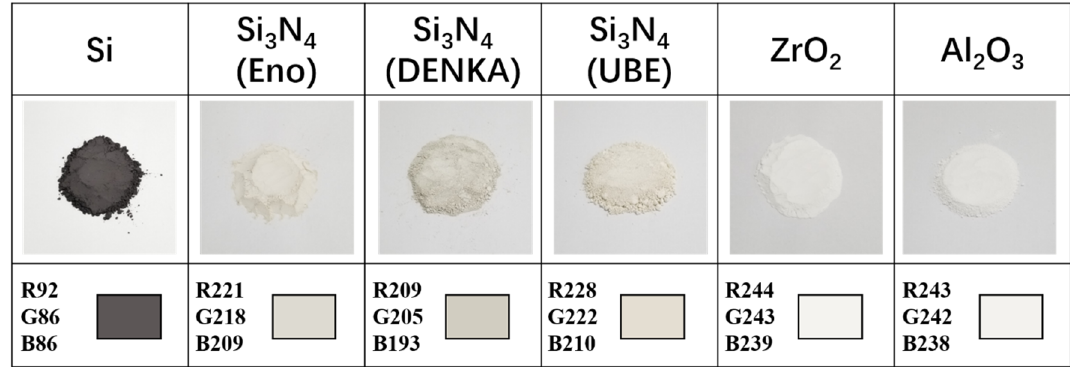
Figure 5. Colors and RGB values of raw powders.